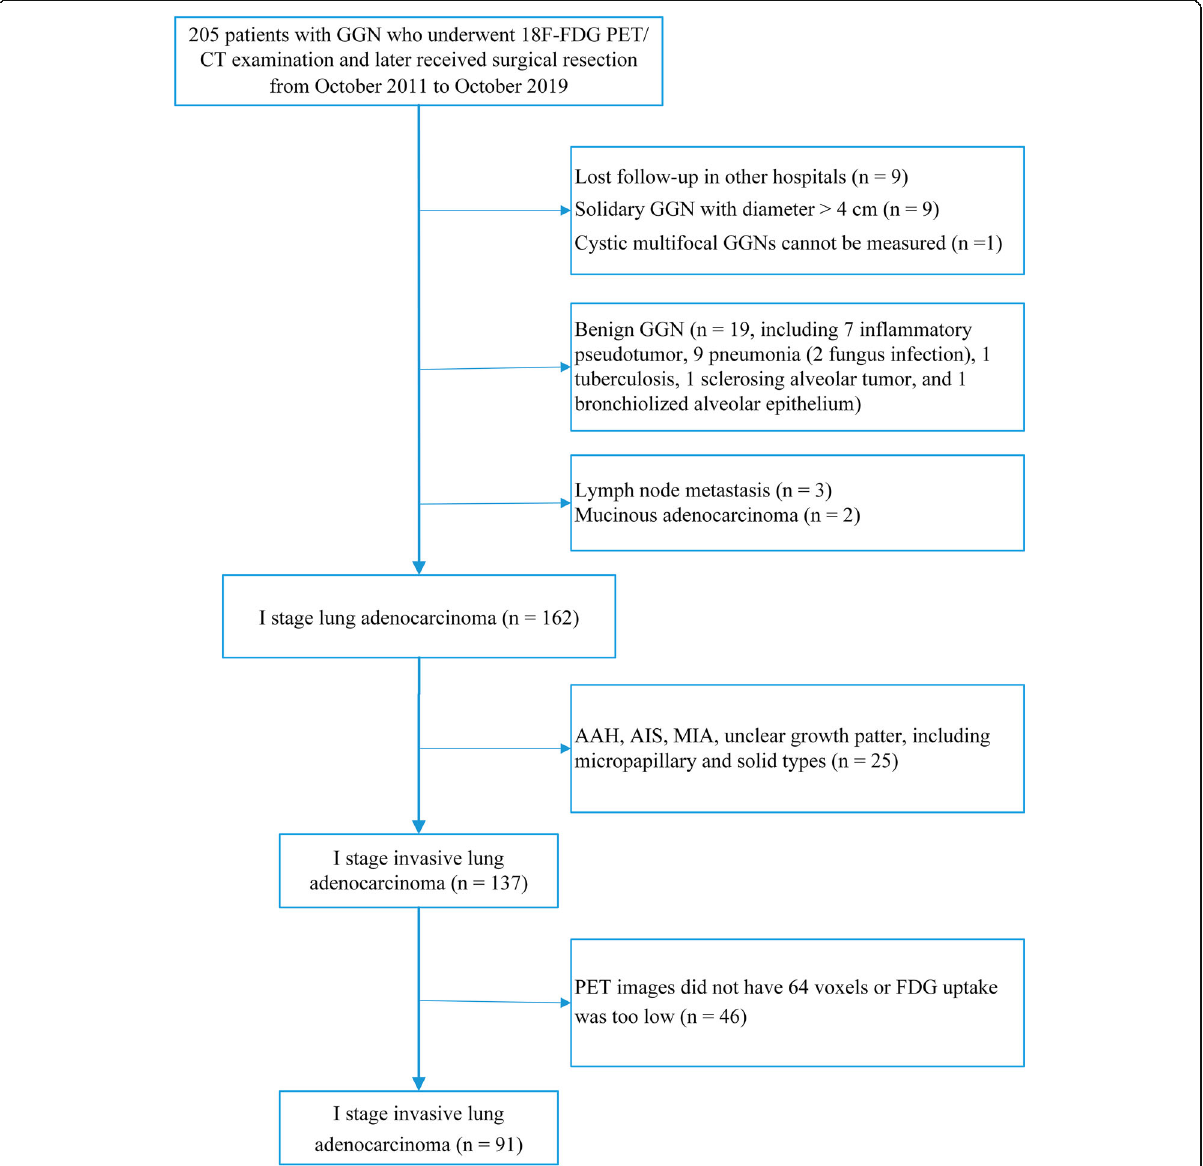
Fig. 1 Flowchart of patient selection. GGN, ground-glass nodule, AAH atypical adenomatous hyperplasia, AIS adenocarcinoma in situ, MIA minimally invasive